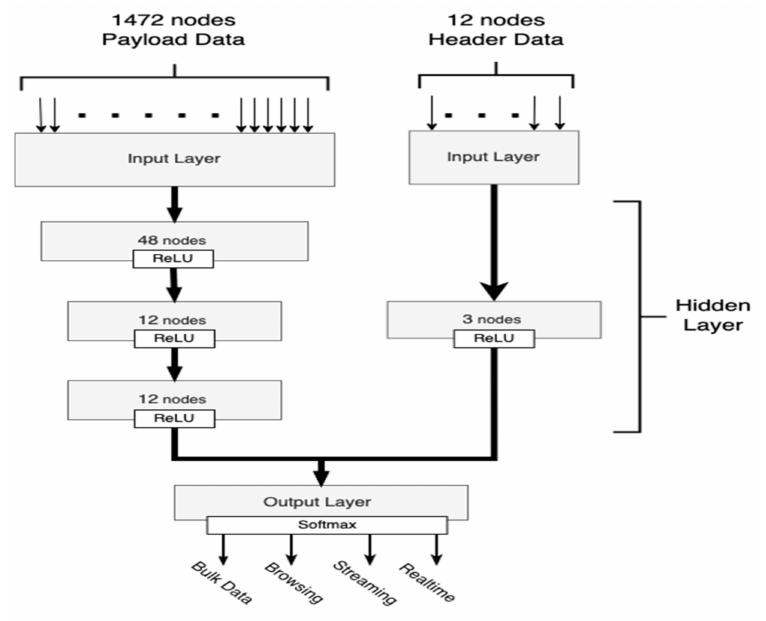
Figure 15. P-MLP model architecture. The training data set used is obtained from the ISCX VPN/non-VPN [25] data set by selecting FTPS, SCP and Email program packets and Wireshark snippet packets, as shown in Table 5. Table 5. Training data set and assigned